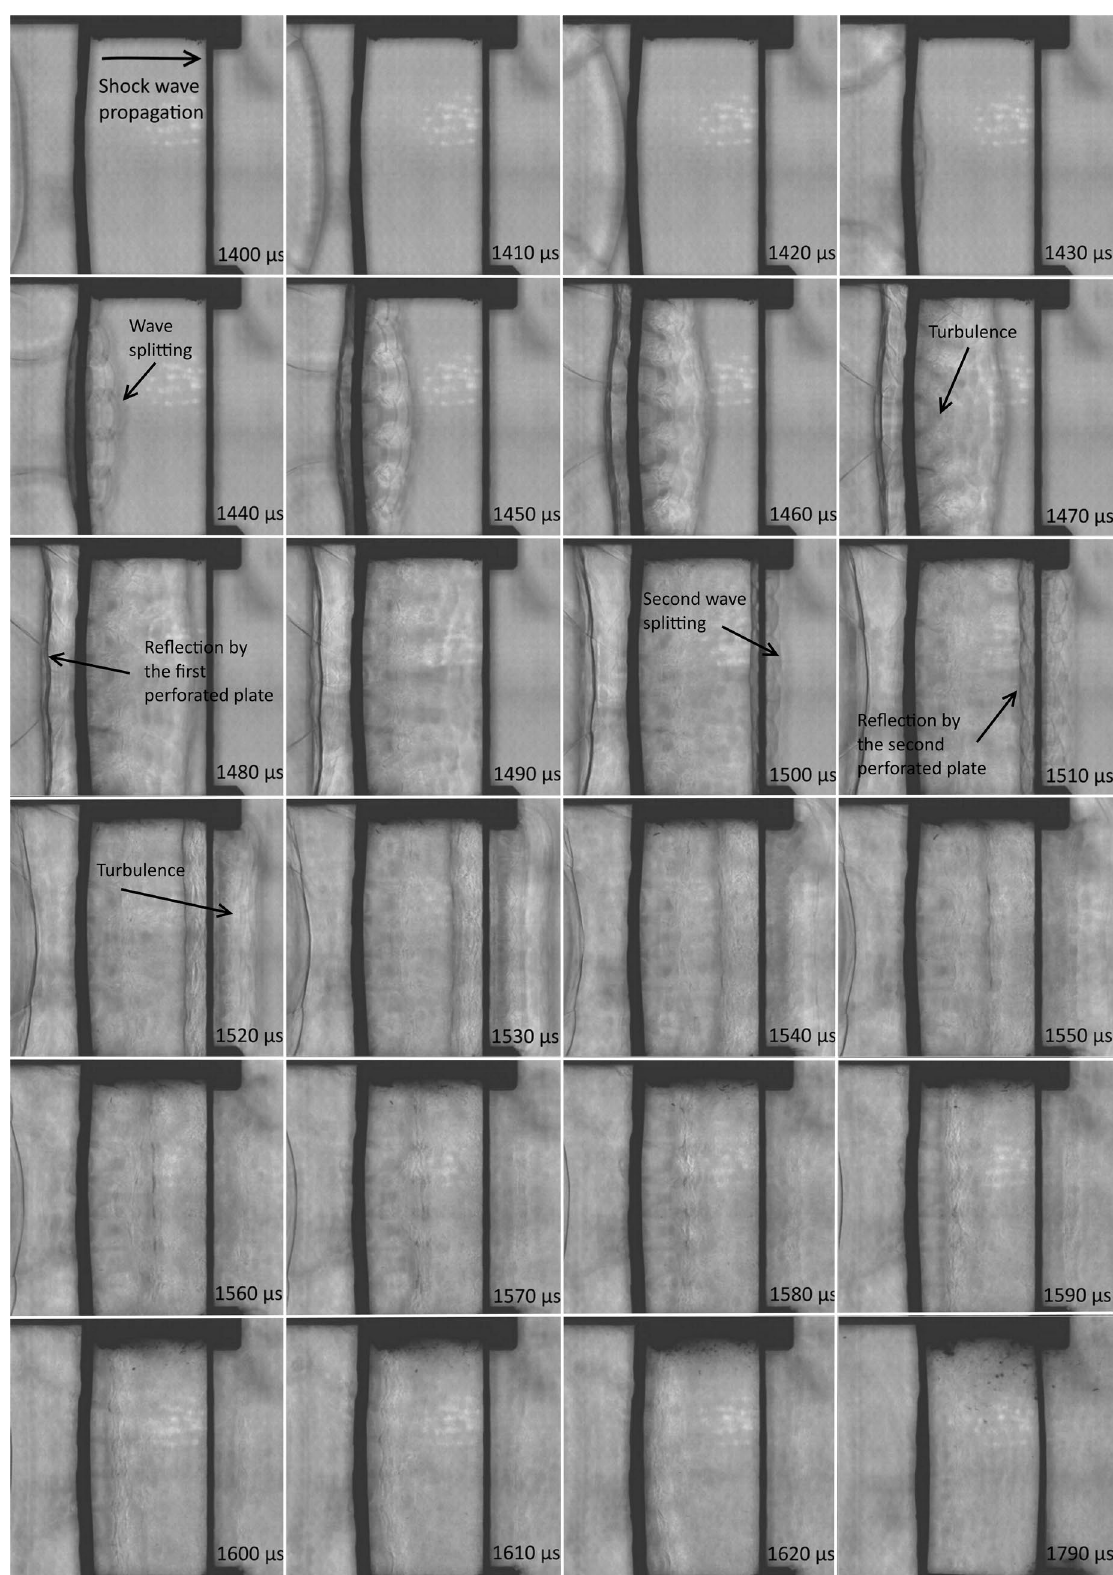
Fig. 8 Photographs resulting from fast video recording, showing the shock wave propagation through the two perforated plates having small round holes (10 µs between each